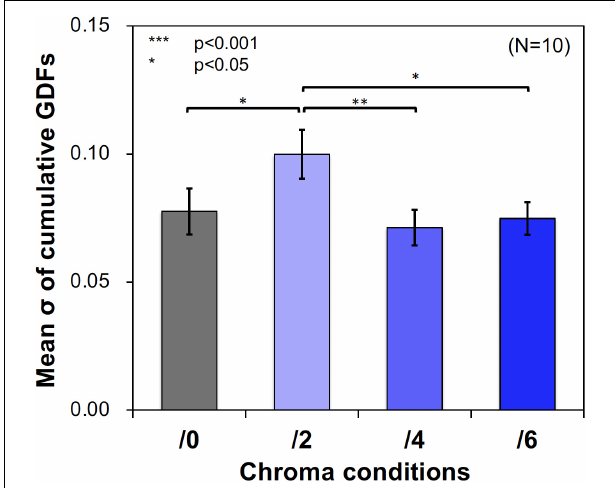
FIGURE 12 | Mean standard deviation ( σ ) of data distributions. Standard deviations were calculated using cumulative Gaussian distribution functions (GDFs) fitted to response rate data of luminance contrast discrimination under the four Chroma conditions (/0, /2, /4, and /6) in the psychophysical experiment. Error bars denote SEM. Asterisks denote statistical significance by Tukey’s HSD test (** p < 0.01; * p < 0.05).